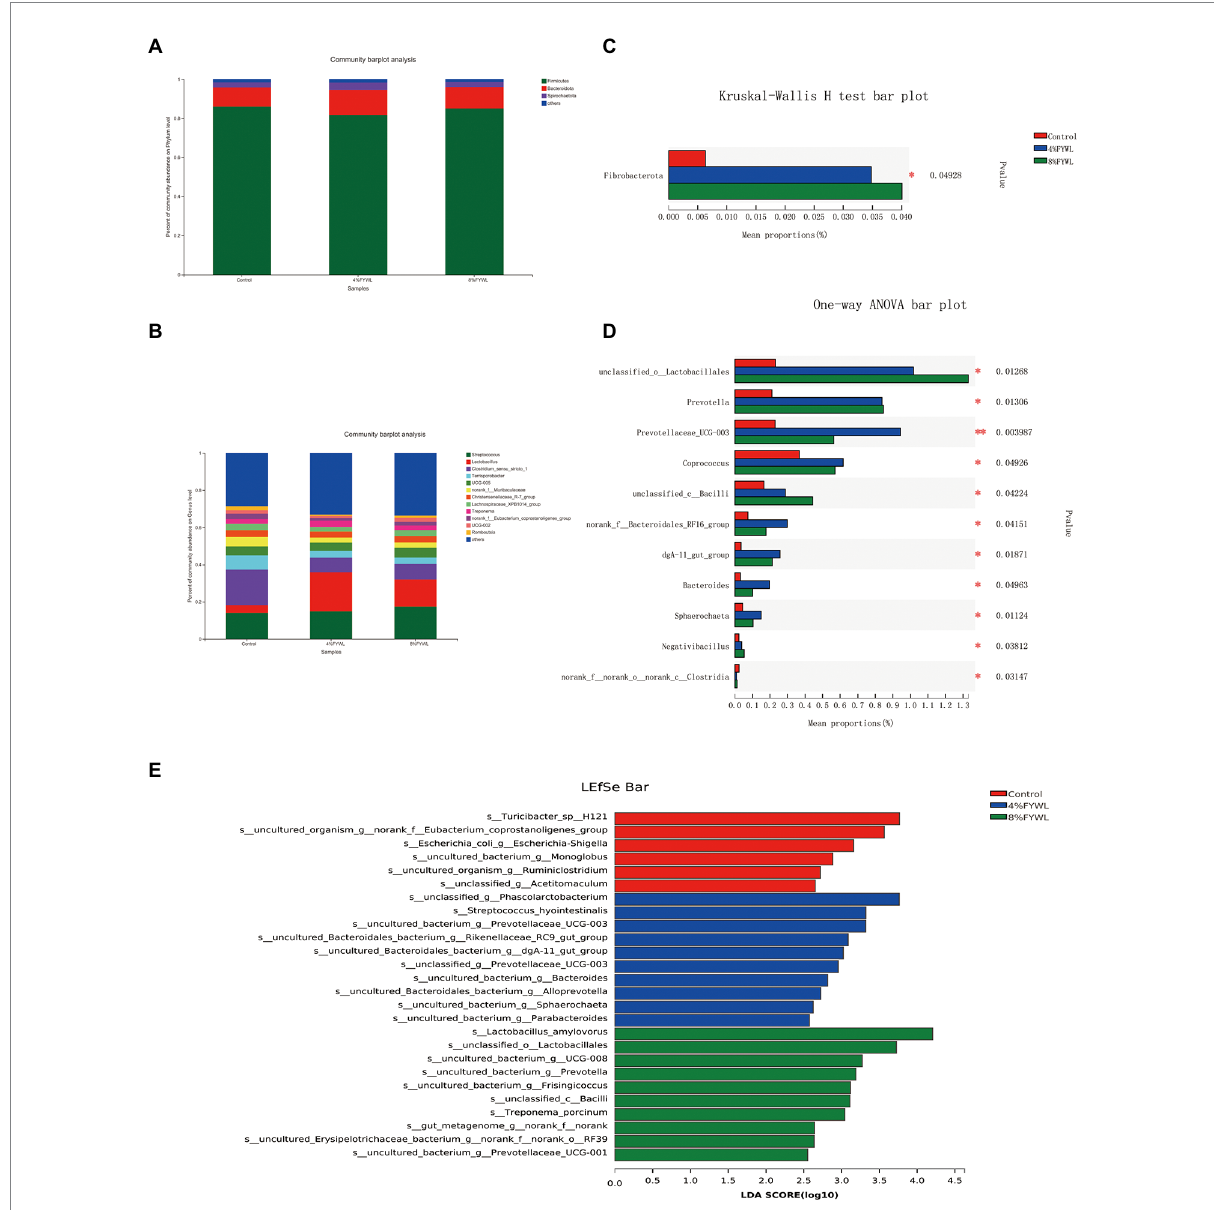
FIGURE 3 Effect of different feeds on the relative abundance of different bacterial species. (A) Phylum-level of the bacterial community in feces. (B) Genus-level of the bacterial community in feces. (C) Phylum-level in Kruskal–Wallis H. (D) , Genus-level in one-way ANOVA. (E) Linear discriminant analysis LDA scores (>2.5) were computed for features. Letters represented the taxonomy of the bacteria: p, phylum, c, class; o, order; f, family; g,